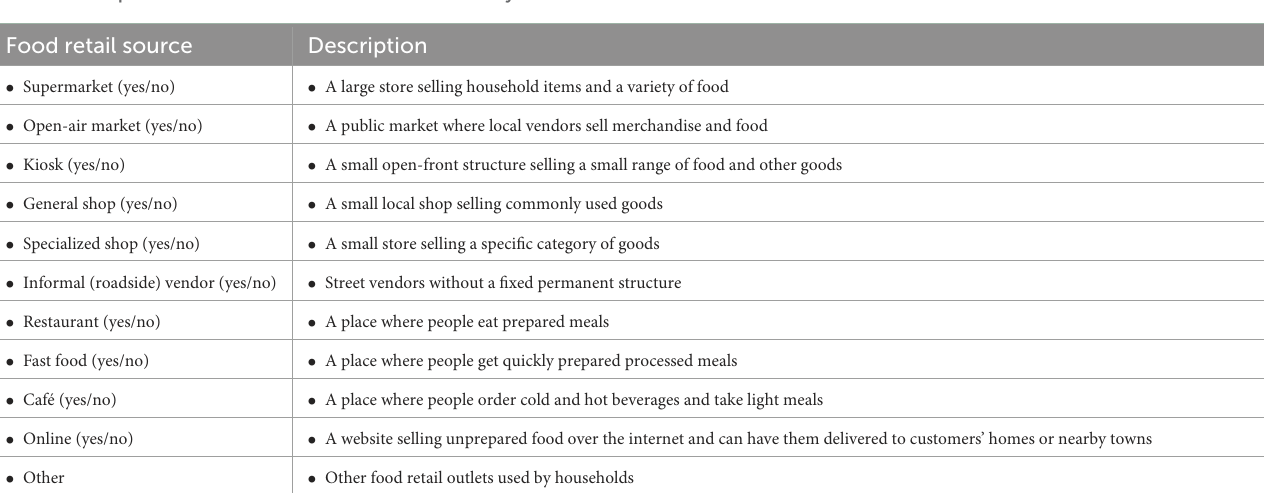
TABLE 1 Description of food retail sources included in the